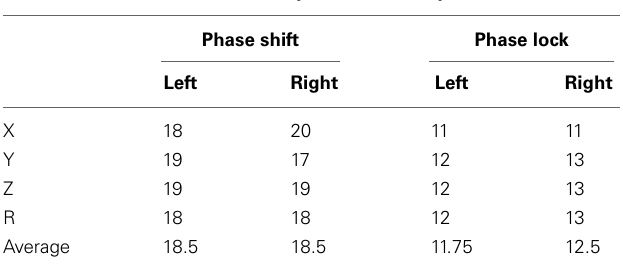
Table 2 | Number of factors that had Eigenvalues of 1.0 or greater for LORETA phase reset in 91 combinations of Brodmann areas for phase shift and lock in the 3-dimensions ( x, y, z ) and also the resultant (cid:2) vector R = x 2 + y 2 + z 2 in the left and right